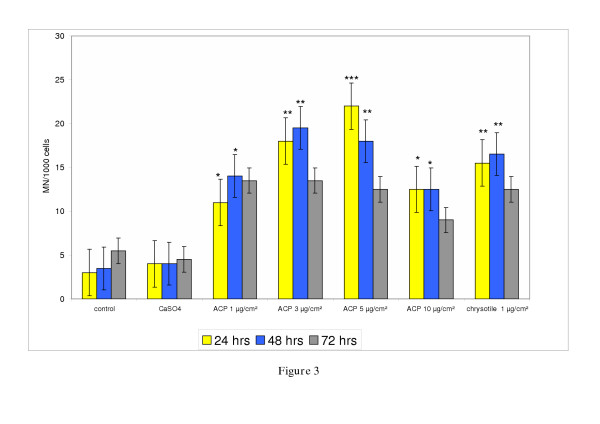
Micronucleus induction after exposure of V79-cells to different doses of asbestos-cement for 24, 48 and 72 hrs. The experiment was repeated twice. Significance: * p < 0.05, ** p < 0.01, *** p < 0.001.